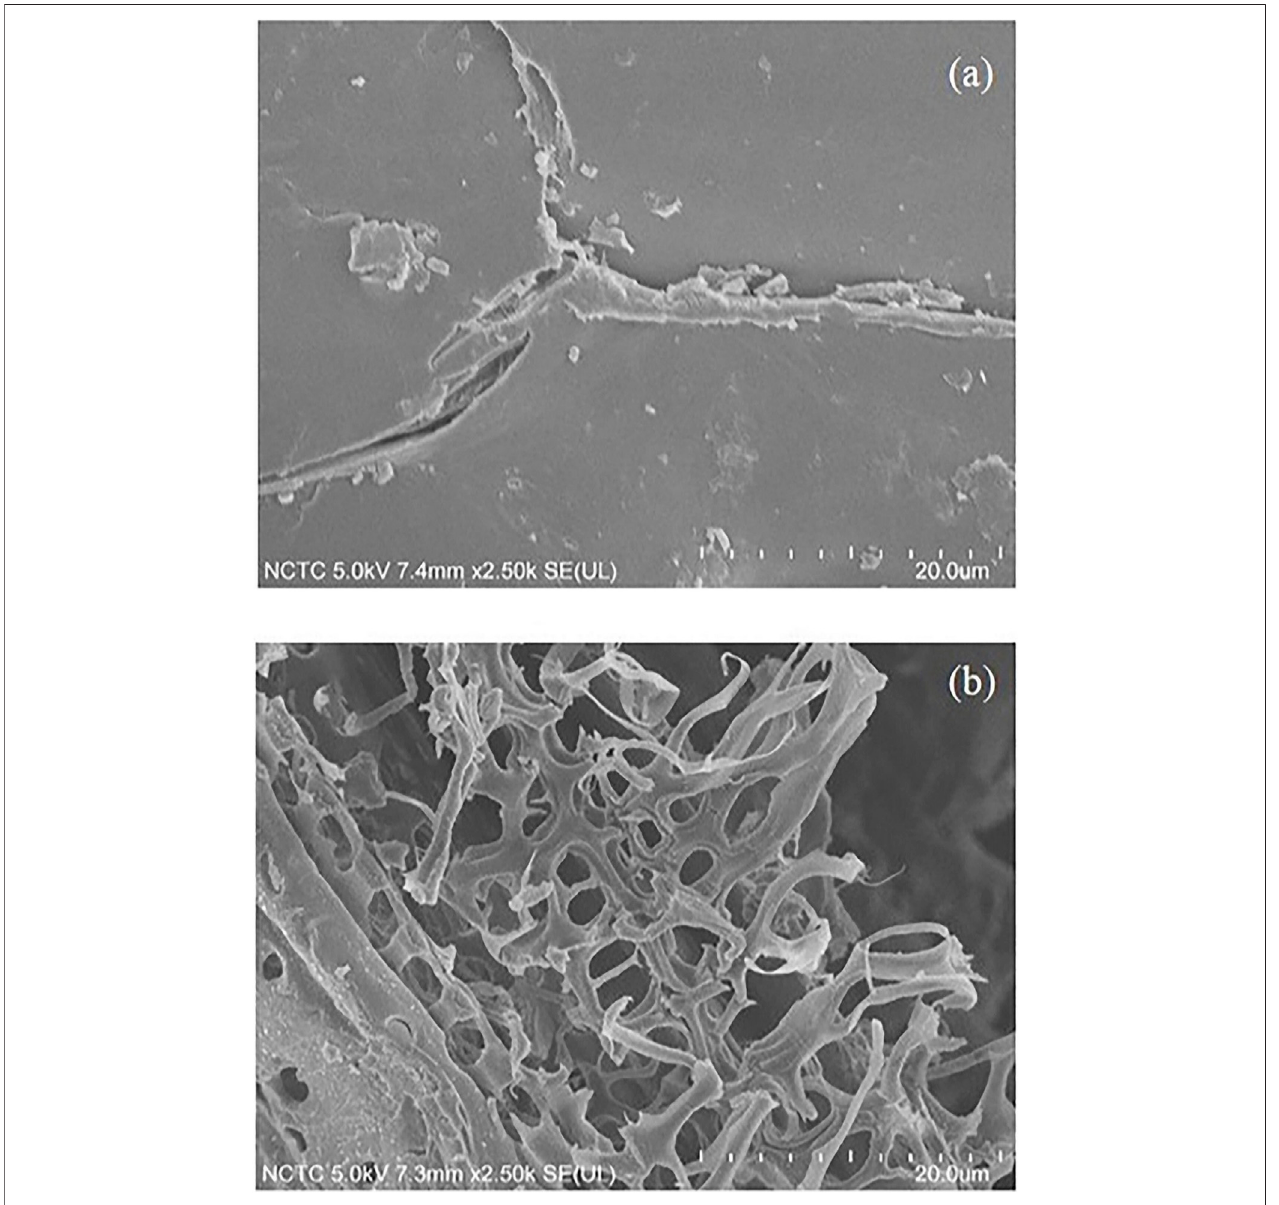
FIGURE 2 | Scanning electron microscopy images of (A) native corn stover and (B) cellulose obtained after the solvothermal fractionation process under the optimal conditions at 0.075 M acid, 180 ° C, and 40 min.